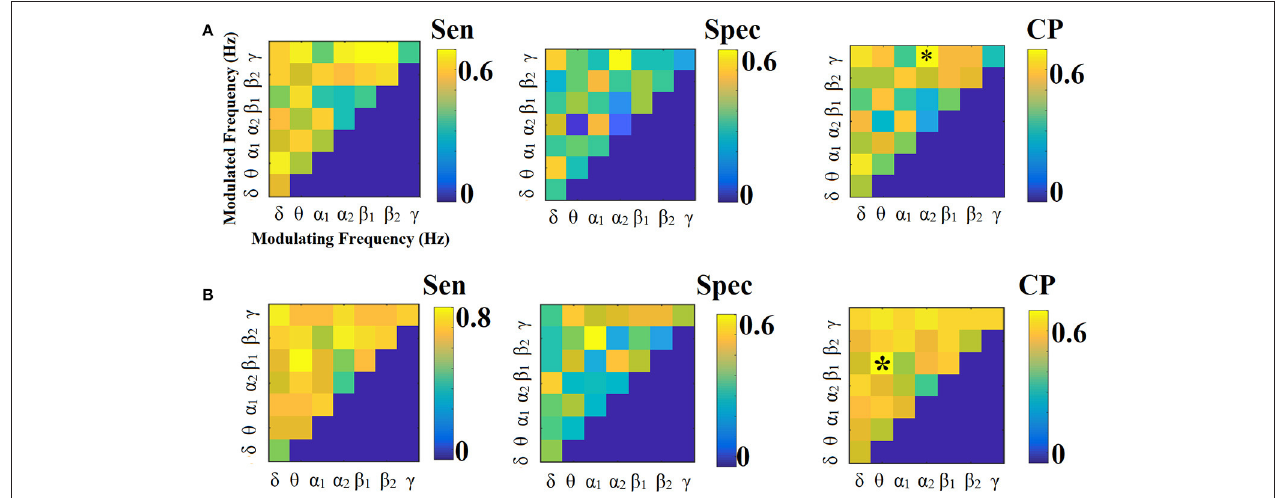
FIGURE 6 | Sensitivity, specificity and classification performance of iPLV using PCA ROI representation and edge-weights approach of each SL-FCG. (A) Sensitivity, specificity and classification performance for the LOOCV. (B) Sensitivity, specificity and classification performance for the 5-fold CV. * denotes the best CP for each CV scheme. Sen, sensitivity; Spec, specificity; CP, classification performance.